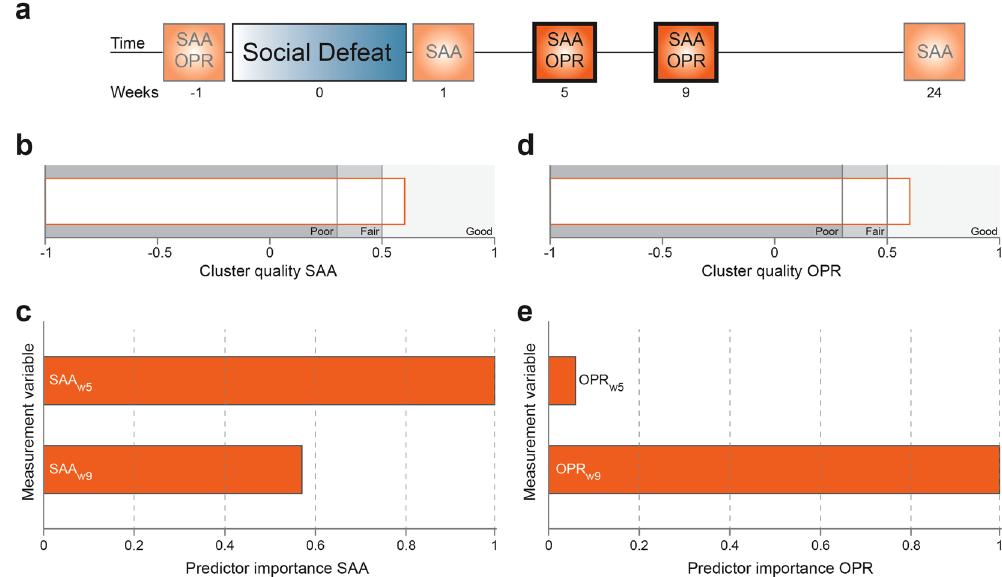
Figure 1. Cluster analysis of depressive-like behaviour over time: Overall model fit and predictor importance. ( a ) Experimental time-line of temporal profiling of affective and cognitive behaviour. Social approach- avoidance (SAA) and object place recognition (OPR) tasks took place in the weeks (w-1, w1, w5, w9, w24) before/after 5 daily defeat sessions (week 0). SDPS-vulnerability was estimated by a two-step cluster analysis of SAA and OPR performance as assessed at weeks 5 and 9 post-defeat (highlighted), using the Schwarz’s Bayesian criterion 35 . ( b ) Cluster quality for affective function (SAA) showed a good overall model fitting (0.60, orange open bar) when including individual data (n = 48) from the SAA w5 and SAA w9 tests. For comparison, poor (0.30) and fair (0.50) model fitting are depicted (grey shading). ( c ) From the two time points, performance at SAA w5 was the most important predictor of SDPS-proneness (predictor importance SAA w5 , 1.00 vs . SAA w9 , 0.57), indicating that SDPS-induced affective deficits that distinguish SDPS-prone from SDPS-resilient animals emerge at 1 month following the last defeat exposure. ( d ) Cluster quality for cognitive function (OPR) showed a good overall model fitting (0.60, orange open bar) when using individual data (n = 48) from the OPR w5 and OPR w9 tests. ( e ) From the two time points, performance at OPR w9 was the most important predictor of SDPS- proneness (predictor importance OPR w9 , 1.00 vs . OPR w5 , 0.06), indicating that cognitive deficits that distinguish SDPS-prone from SDPS-resilient animals develop later, namely at 2 months following the last defeat